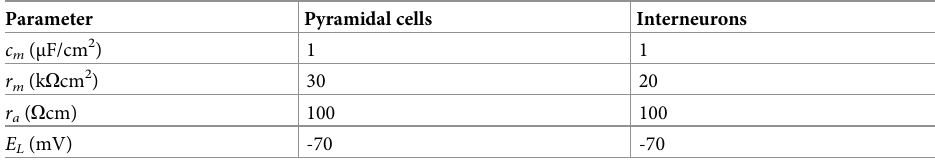
Table 7. Parameters of multicompartment